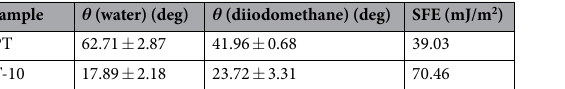
Table 2. Contact angle ( θ ) and surface free energy (SFE) of untreated PT sample and treated T-10